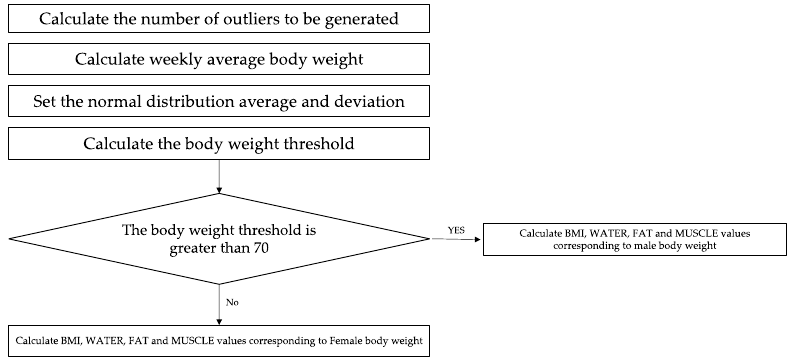
Figure 3. The Generation module: this module uses a normal distribution based on gender physical